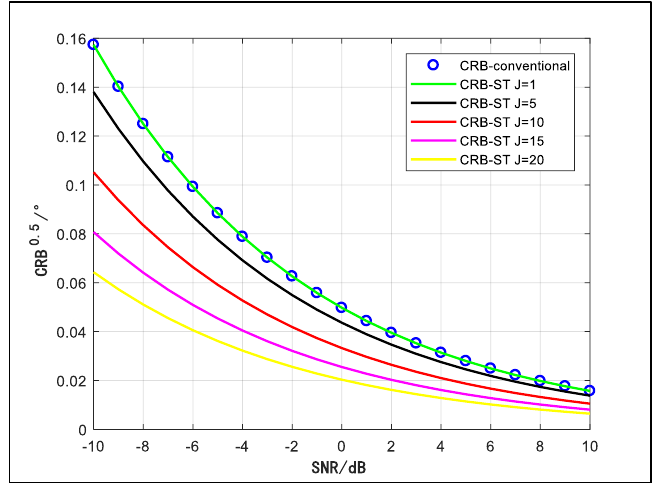
Figure 6. CRB versus SNR for different values of the temporal dimension. Figure 7. CRB versus SNR for different values of the temporal